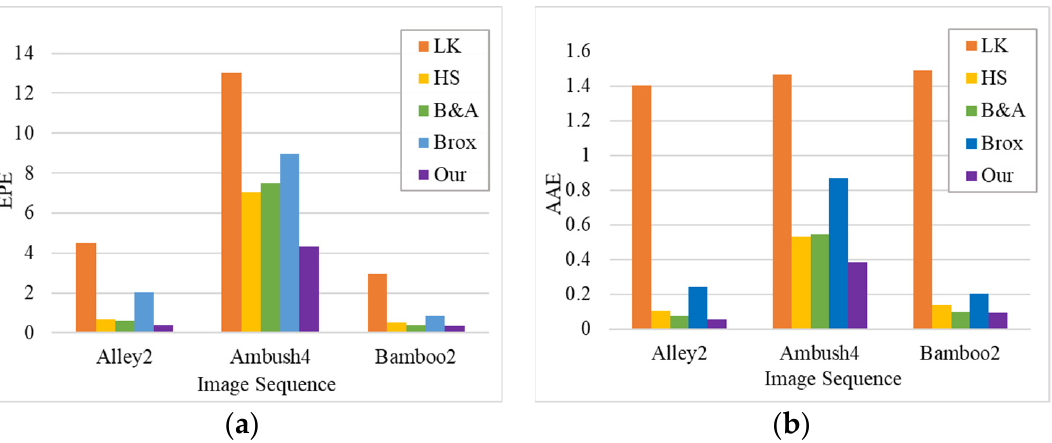
Figure 7. Error comparison of optical flow estimation algorithms. ( a ) is the EPE comparison result and ( b ) is the AAE comparison result.